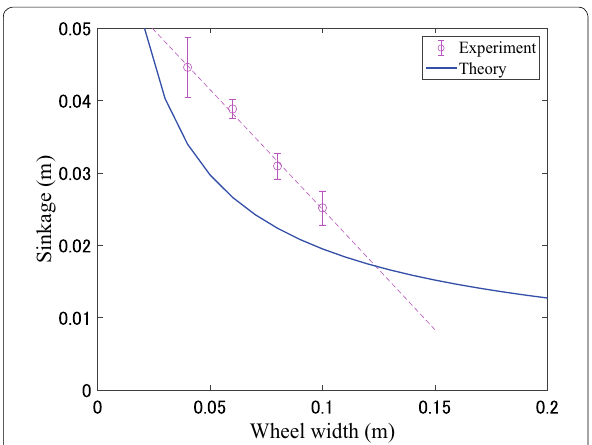
SD steady-state sinkage at different wheel width. Fig. 13 Mean ± Diameter 0.17 m; mass 2.5 kg